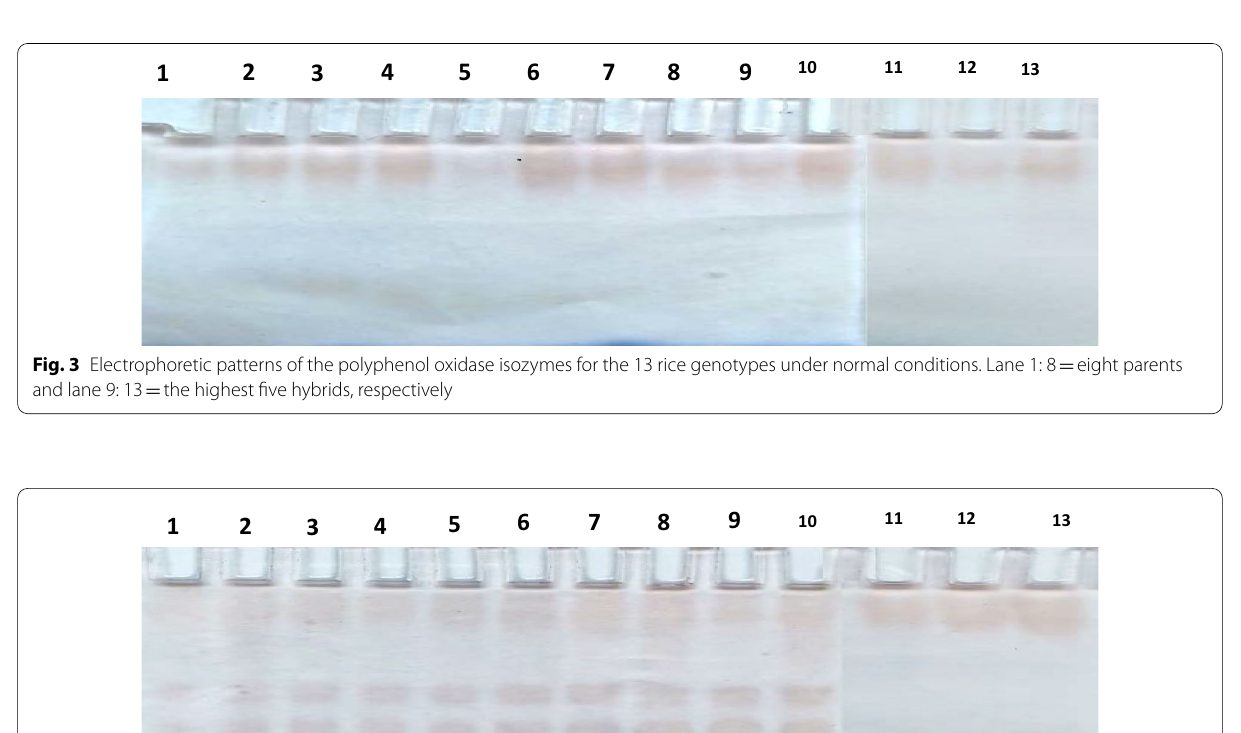
Fig. 4 Electrophoretic patterns of the polyphenol oxidase isozymes for the 13 rice genotypes under drought conditions. Lane 1: 8 and lane 9: 13 the highest five hybrids, =